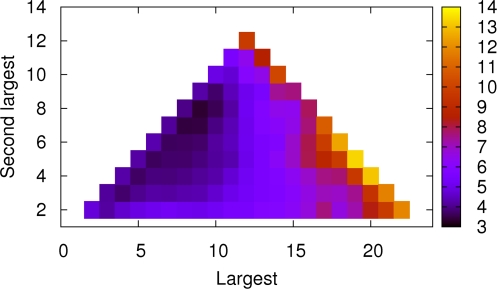
Statistical analysis of aggregate sizes in our 72 unseeded 24-chain runs.The quantity shown is −log H(x,y), where x and y denote the sizes of the largest and next-largest aggregates, respectively, in a given conformation; H(x,y) is the histogram of x and y. Conformations were recorded at regular time intervals in the second half of the runs.